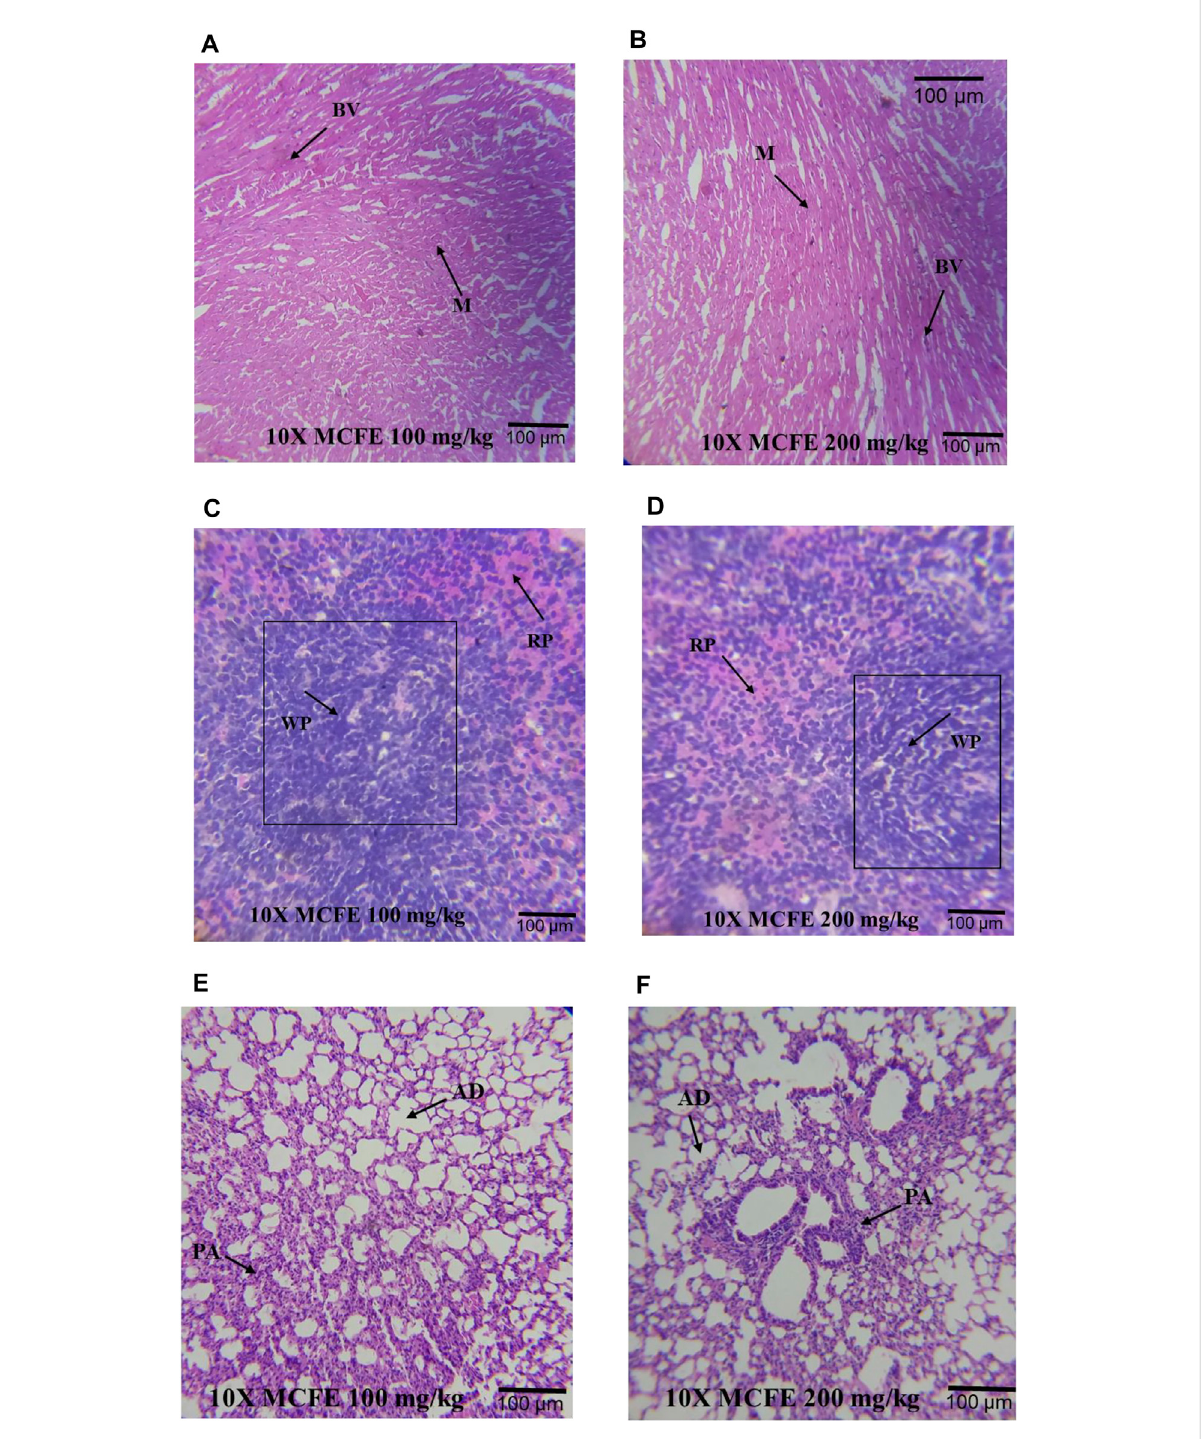
FIGURE 7 Photomicrographs at 10× magni fi cations of haematoxylin and eosin (H&E) stained heart (A) and (B) ; spleen (C) and (D) ; lung (E) and (F) , when MCFE is administered at different doses. *Blood vessels (BV), Myocardium (M), Red pulp (red) (RP), White pulp (WP), Pulmonary artery (PA) and Alveolar duct